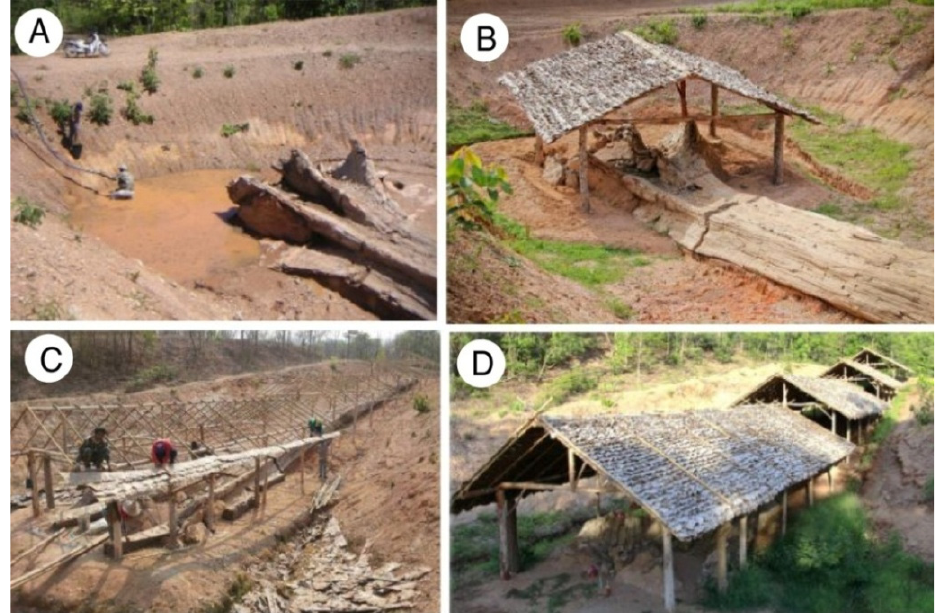
Figure 22. Early conservation at Tak. ( A ) Log BT-7 flooded at the buttress in 2006. Photo from the national park staff. ( B ) BT-7 temporary shelter and drainage in 2013. Photo by Nakaporn Limrachtamorn. ( C ) Construction of a temporary shelter by park staff and the locals. ( D ) Completed temporary shelter.